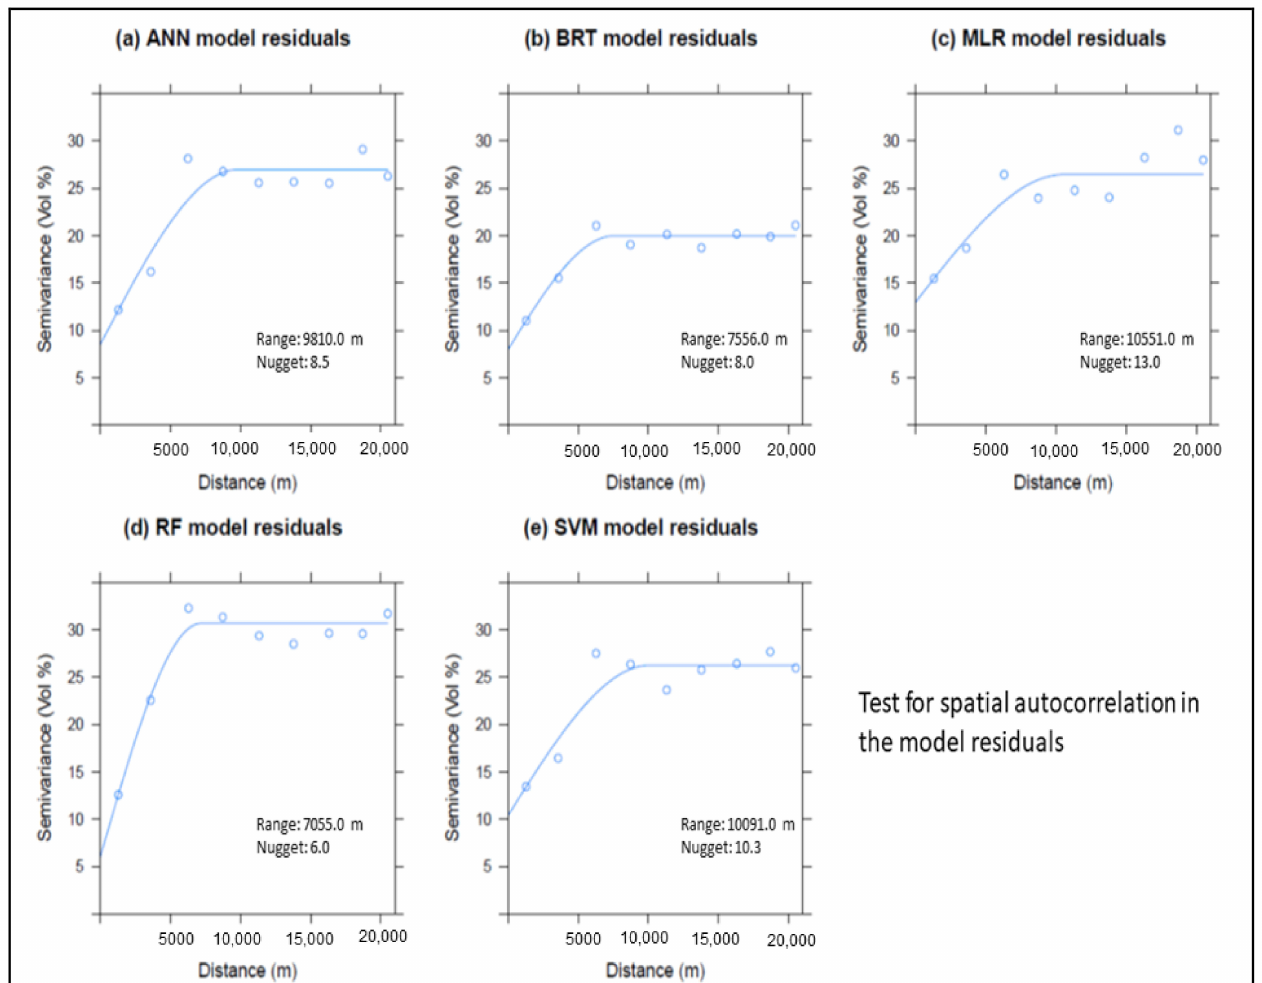
Figure 5. Spatial autocorrelation observed in the model residuals for the water content at pF0.0 in the topsoil (0–30 cm) depth layers. ( a ) ANN, artificial neural network; ( b ) BRT, gradient boosted regression trees; ( c ) MLR, multiple linear regression; ( d ) RF, random forest; ( e ) SVM, support vector